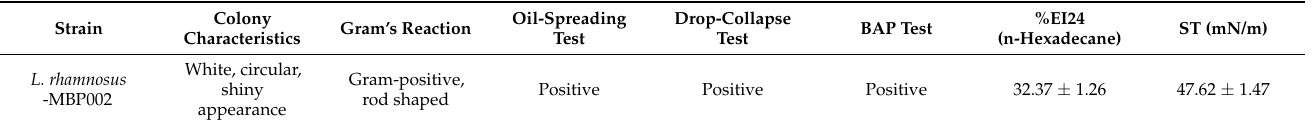
Table 1. Qualitative and quantitative results of the different screening assays for the production of biosurfactants (values are the mean ± SD ( n =